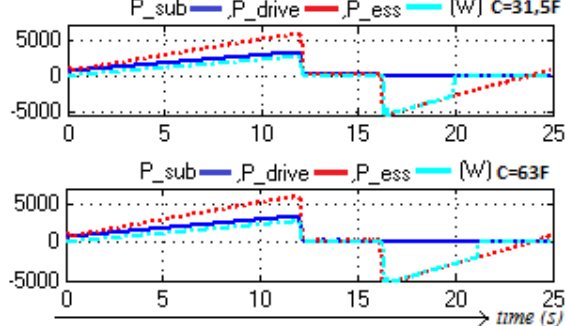
Fig. 17. Simulation diagrams of power for both C = 31.5 F and C = 63 F.